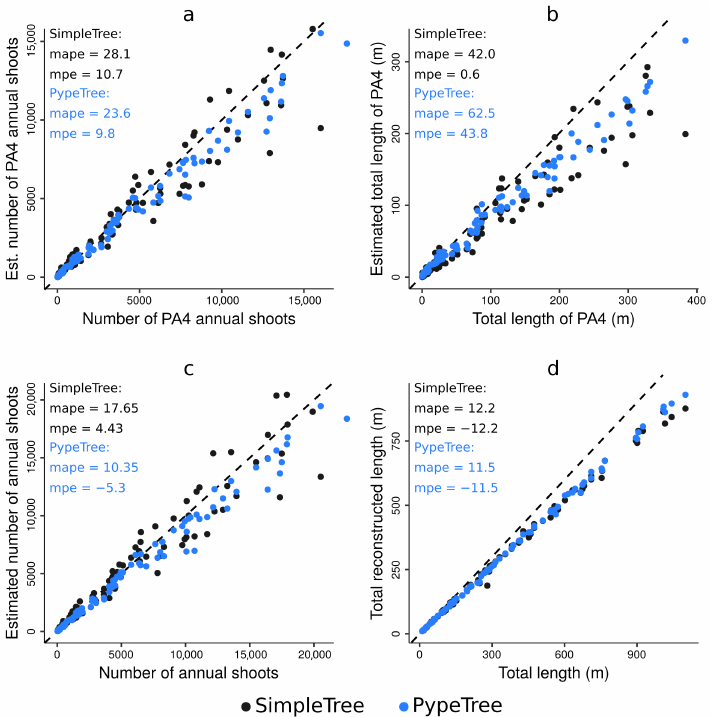
Figure 14. Number and length of PA4 annual shoots and reconstructed total length after the addition of non-reconstructed PA4 using a simple architectural automaton. The number of annual shoot is evaluated for PA4 only ( a ) or for all PA at the tree level ( c ) as well as the total reconstructed length (( b , d ), respectively). The Mean Absolute Percentage Error (mape, %) and Mean Percentage Error (mpe, %) are indicated on the